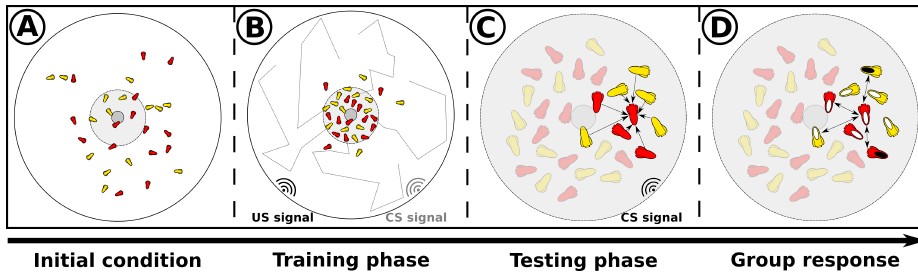
Figure 4. Timeline of an experiment, with four main situations represented. ( A ) In the initial condi- tion, robots are randomly scattered in the pool. ( B ) In the training phase, the robots can be exposed two different conditions, either the unconditional stimulus alone, or both the unconditional and the conditional stimuli together. During this time, robots perform a random walk and aggregate under the beacon, in a mixed or segregated configuration depending on the stimuli perceived. ( C ) In the testing phase, once robots are aggregated, the conditional stimulus is triggered alone to test whether robots have learned to associate it with the unconditional stimulus. Robots observe their immediate neighbors to form an opinion about their local configuration. ( D ) To obtain a collective response, robots exchange their opinions in a peer to peer manner and converge to a single opinion.